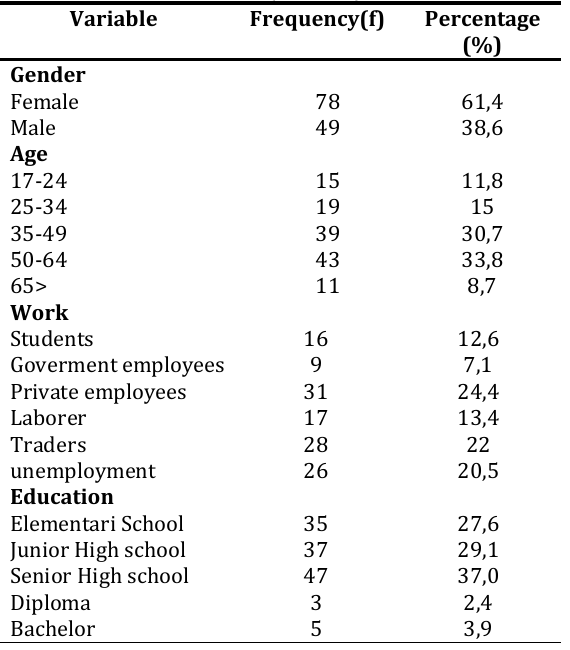
Table 1. Respondent Frequency Distribution Based on Gender, Age, Work, and Education Patients in the ward on December 2018 (n = 127)